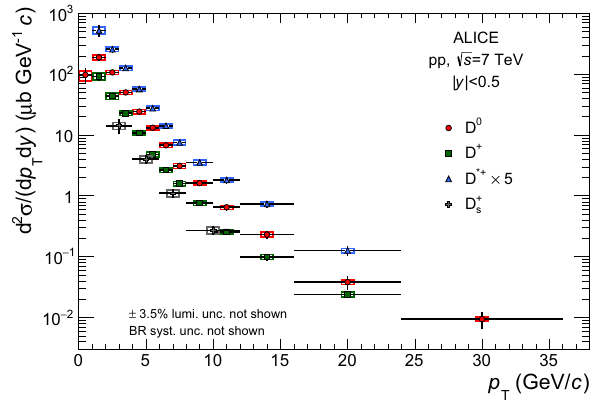
Fig. 3 p T -differentialinclusiveproductioncrosssectionofpromptD 0 , D + , D ∗+ and D + s mesons in pp collisions at uncertainties( bars )andsystematicuncertainties( boxes )areshown.The D ∗+ cross section is scaled by a factor of 5 for better visibility